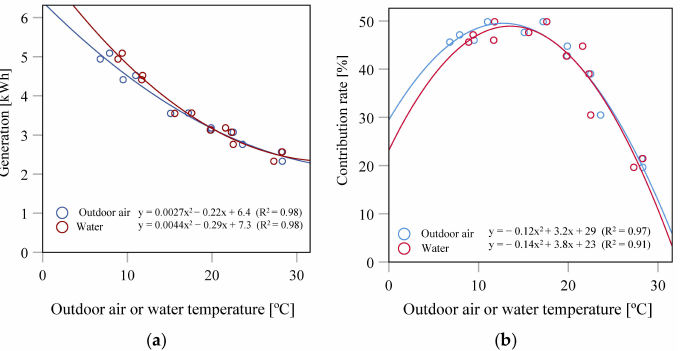
Figure 10. Relationship between the energy-saving effect of cogeneration system (CGS) and the outdoor air or water temperature (n = 12): ( a ) generation; ( b ) contribution